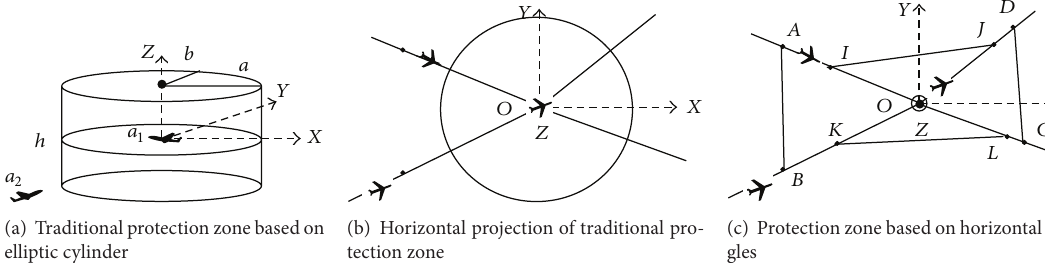
Figure 3: Two different protection zones.